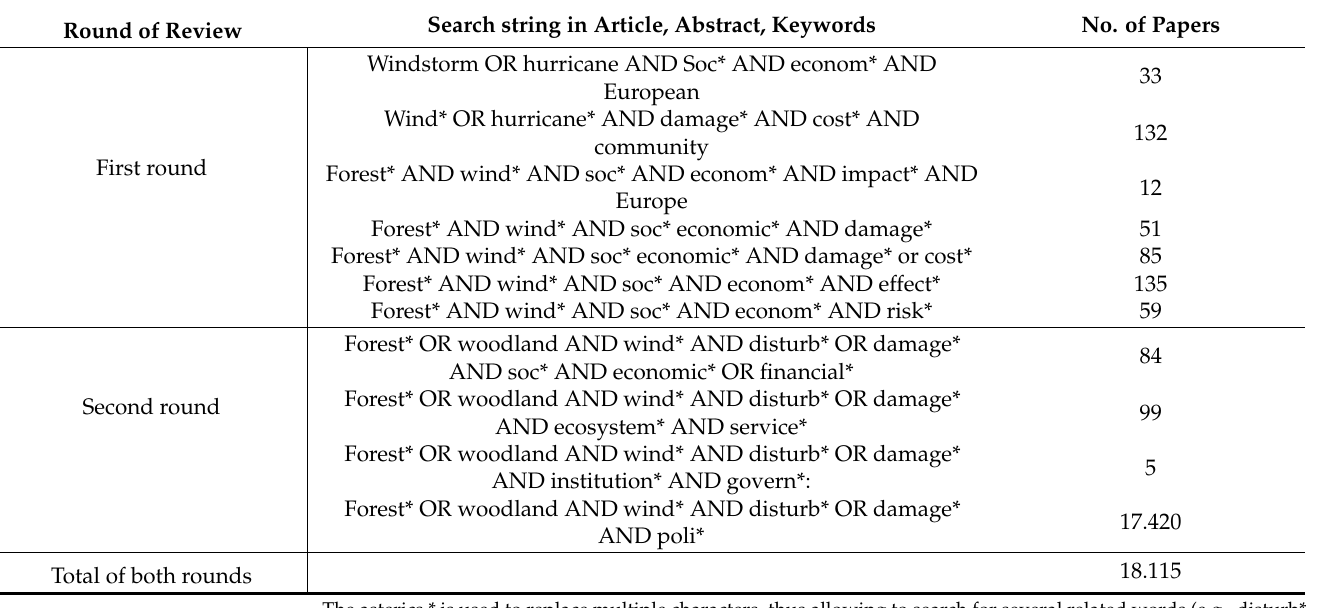
Table A1. List of search strings used in Scopus database for paper